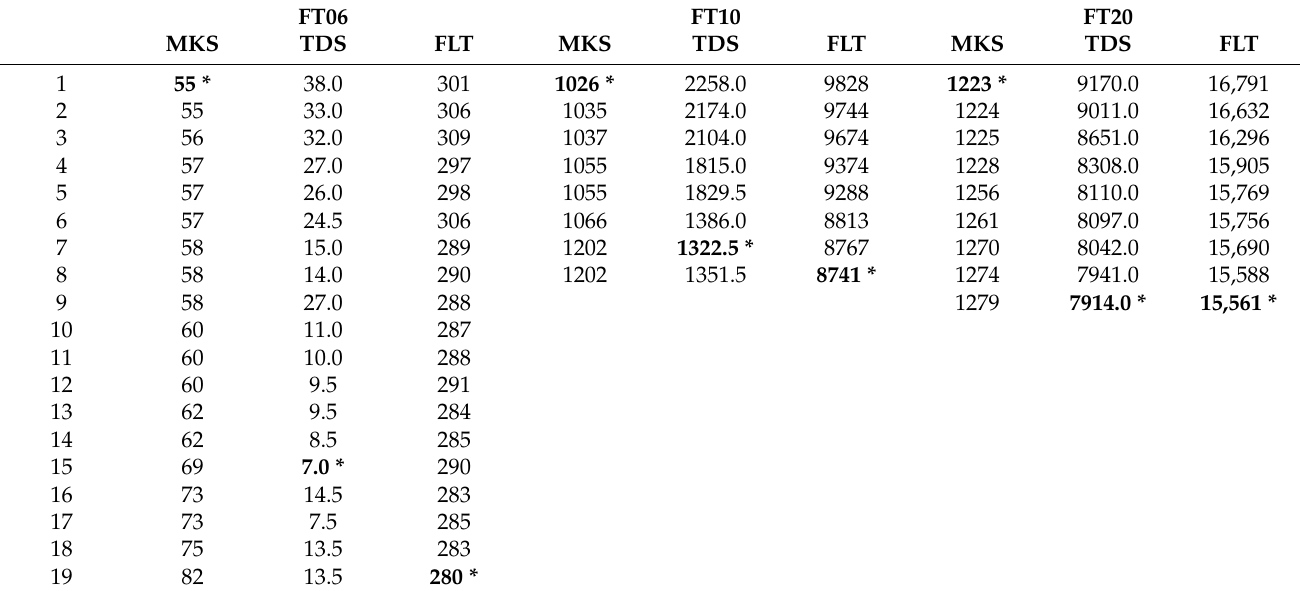
Table A1. Non-dominated solutions obtained by SS/LS for the JSSP instances proposed by [20].